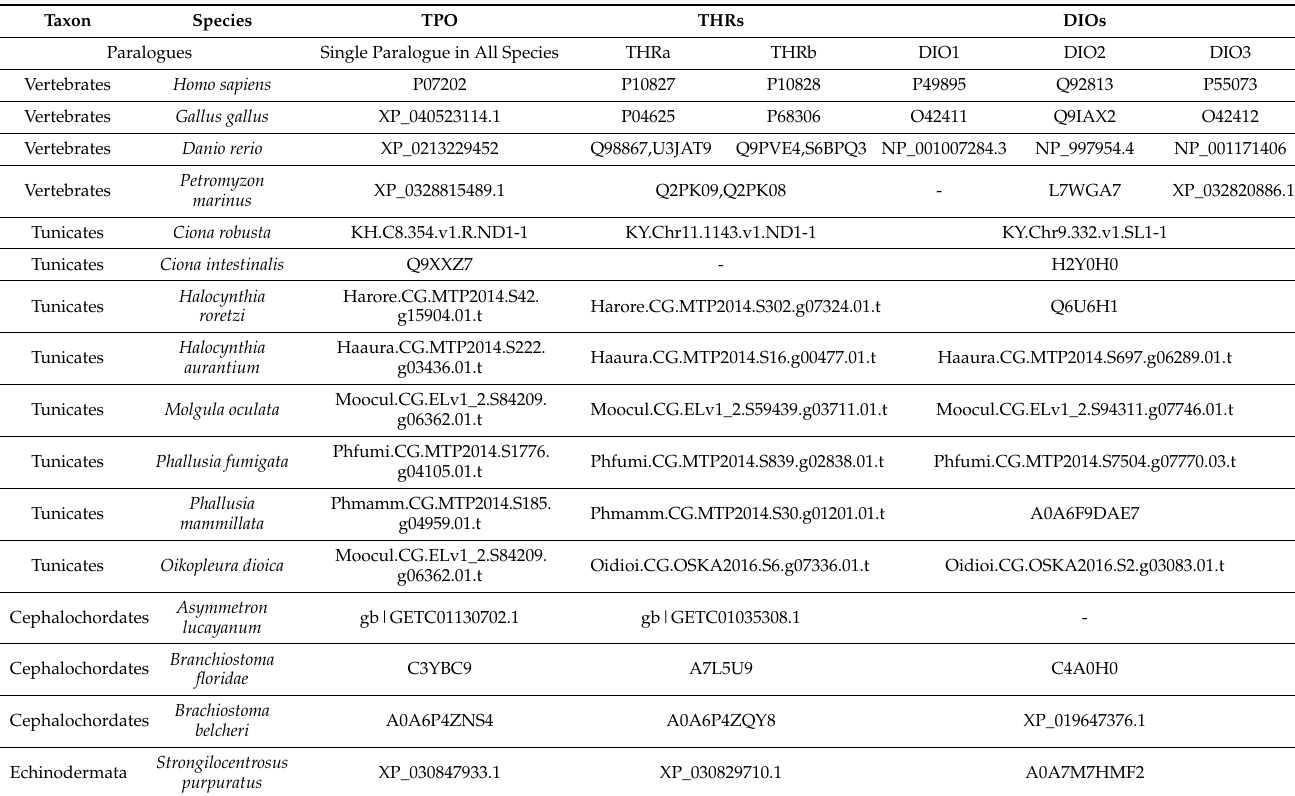
Table 1. Summary of the sequences retrieved from the UniProt database or inferred by sequence similarity searches; all sequences can be found in Supplementary Material Files